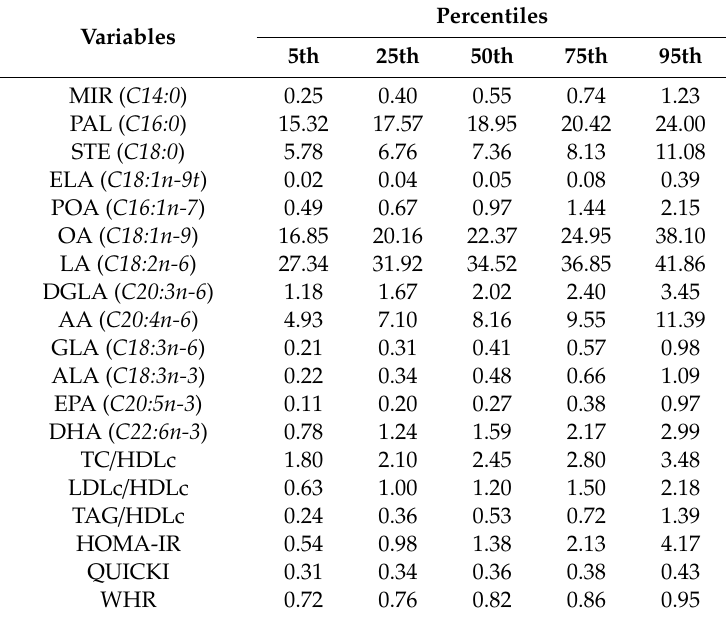
Table 2. Percentiles of fatty acid percentages and main cardiometabolic indexes. Percentiles Variables 5th 25th 50th 75th